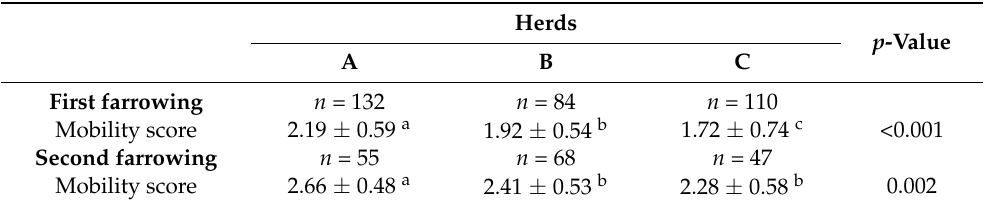
Table 8. Results of mobility score (mean ± SD) of replacement gilts of different genetic lines in three farrow-to-finish herds in Greece, at first and second farrowing.